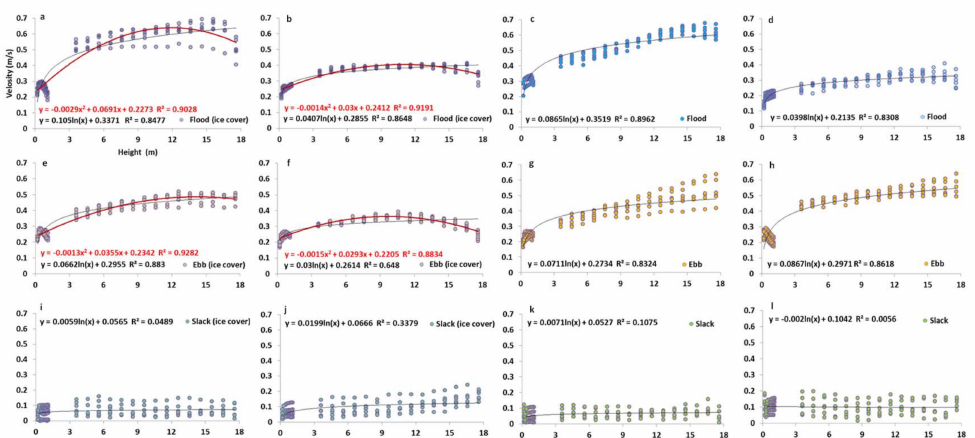
Figure 10. Scatter plots and fitting relations of current velocity at di ff erent heights from the bottom in di ff erent tidal phases during typical spring tide periods: ( a , b ) the periods of flood tide with ice cover on February 2 and 3; ( c , d ) the periods of flood tide without ice cover on February 17 and 18; ( e , f ) the periods of ebb tide with ice cover on February 3 and 4; ( g , h ) the periods of ebb tide without ice cover on February 18 and 19; ( i , j ) two periods of slack water with ice cover on February 3; ( k , l ) two periods of slack water without ice cover on February